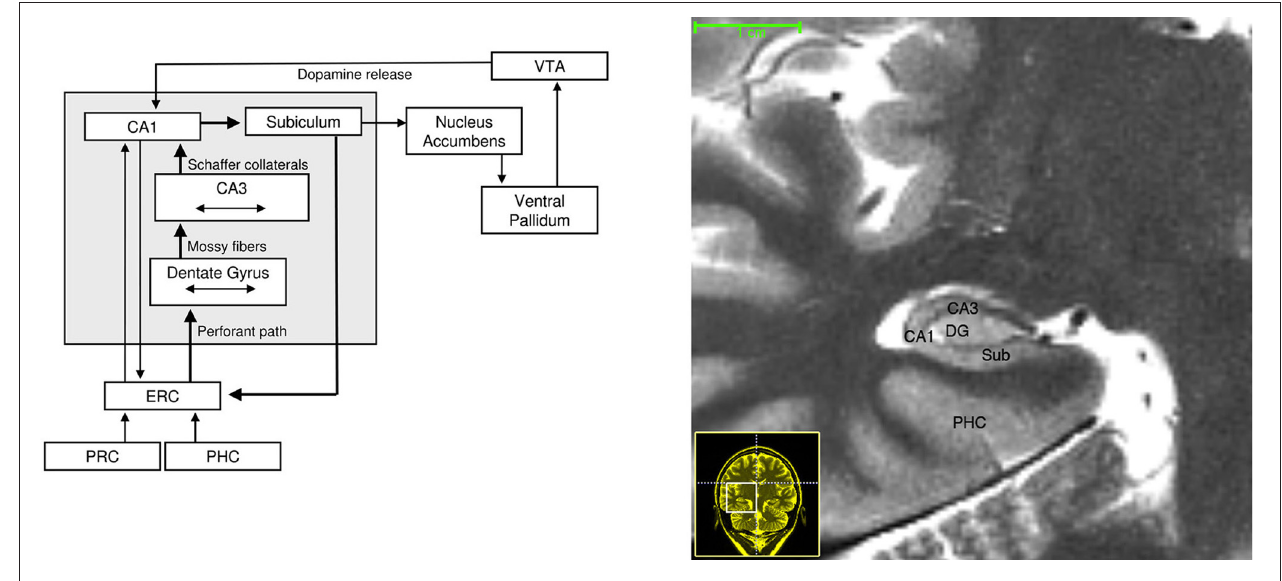
FIGURE 2 | Left: Neuroanatomical circuitry that supports binding and comparison. Arrows depict major connections between medial temporal lobe subregions that enable information flow. Brain regions that provide dopaminergic modulation are also depicted.